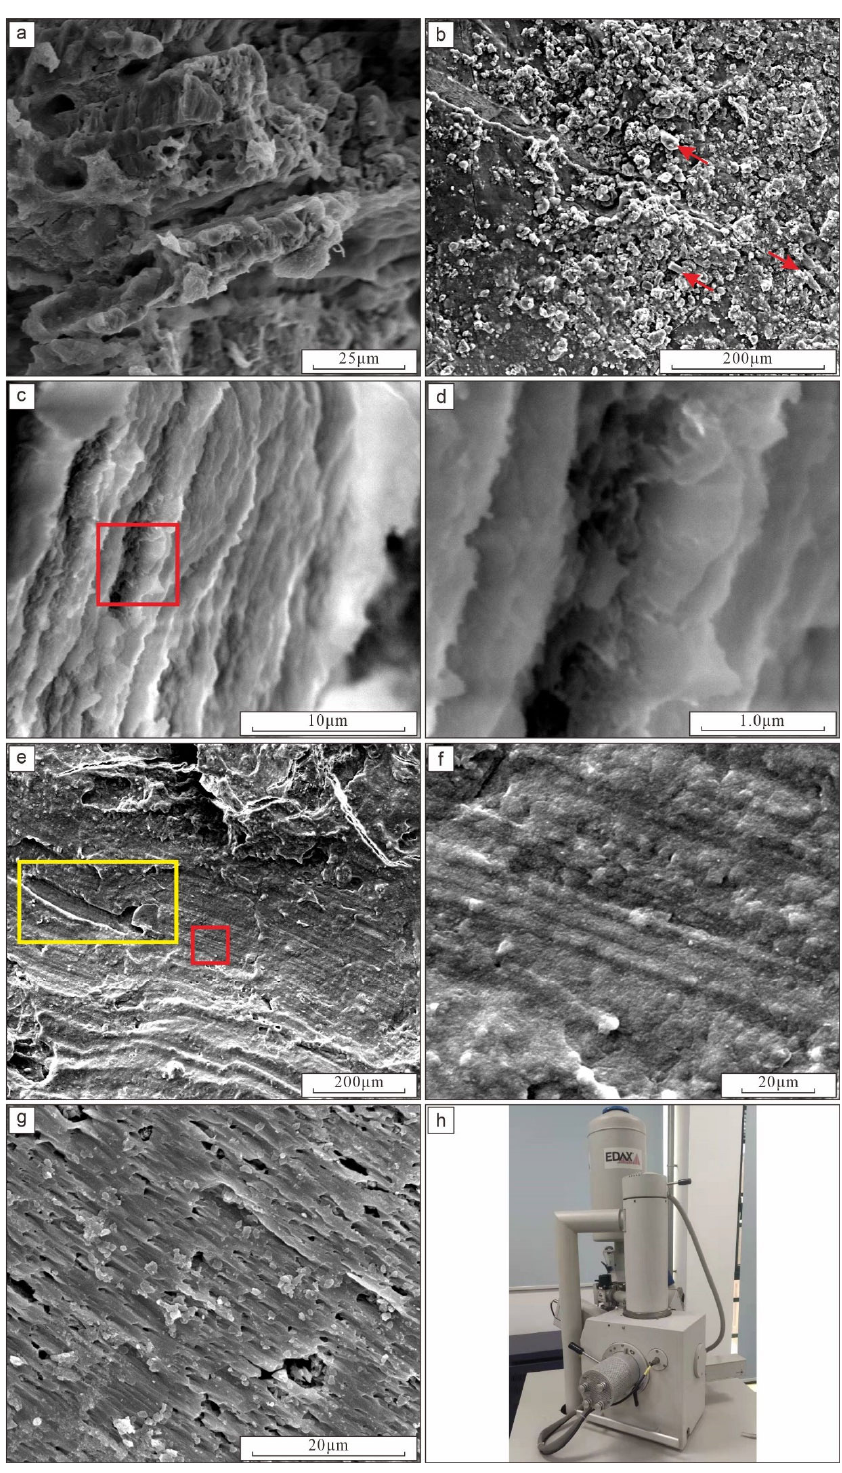
Figure 10. Microstructure of Shangfang landslide slip soil and the SEM. ( a ) Directional arrangement of flaky minerals (1200×). ( b ) Directional arrangement of mineral particles such as quartz (250×). ( c ) Layered arrangement of clay minerals (5000×). ( d ) Magnified image of layered arrangement of clay minerals (20,000×). ( e ) Arc scratches (yellow box) and straight scratches (red box) (150×). ( f ) Magnified image of straight scratches (1200×). ( g ) Leaching structure of granite (2500×). ( h ) FEI Quanta 200 SEM.